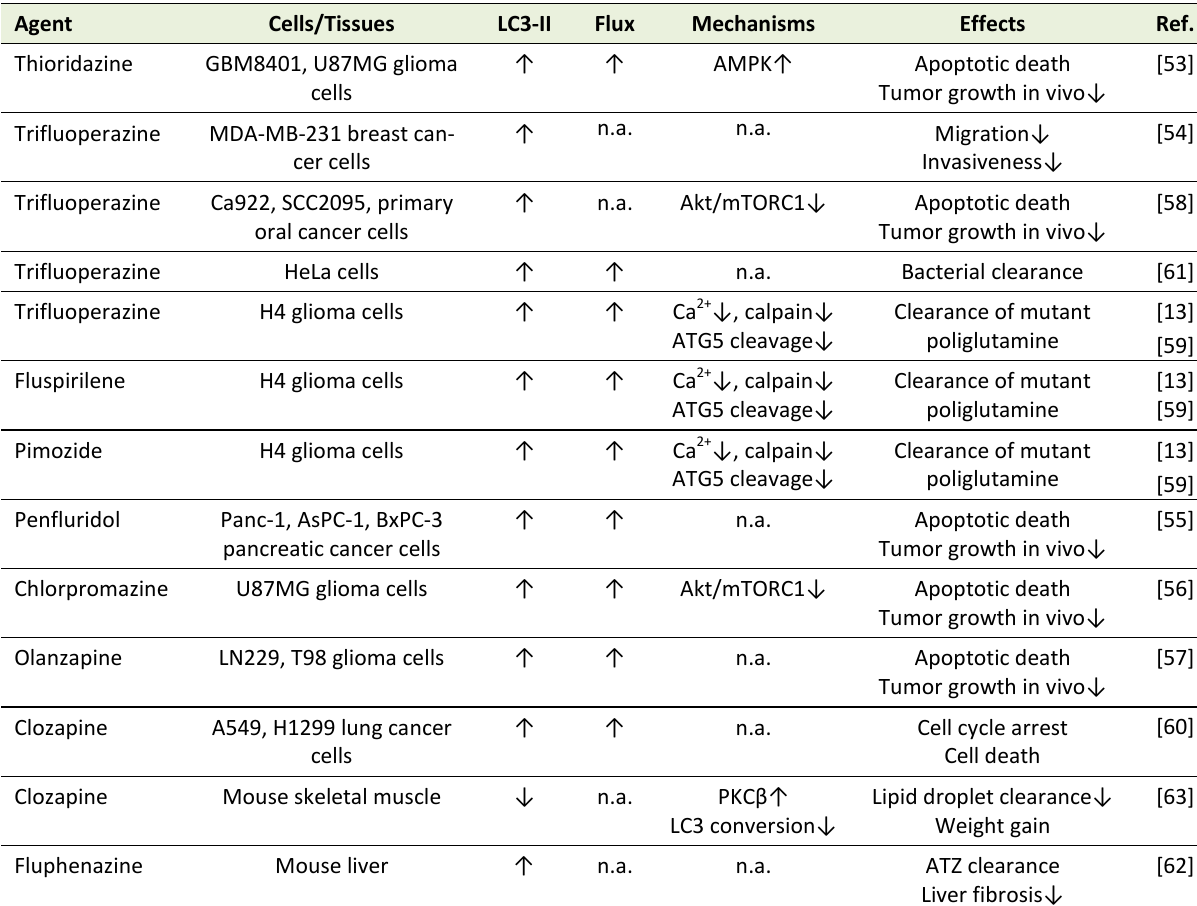
Table 2. Modulation of autophagy by antipsychotics in non-neuronal